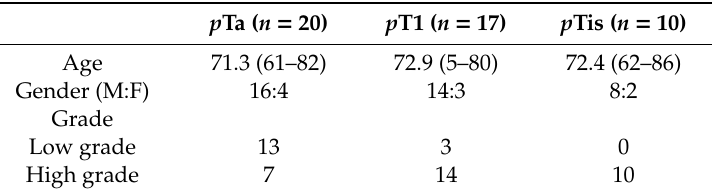
Table 1. Characterization of urothelial